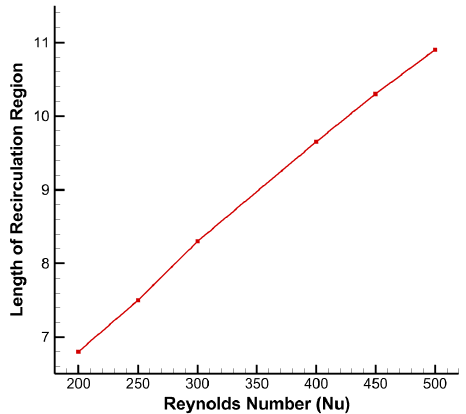
Figure 9. Length of primary recirculation region behind the backward facing step having an expansion ratio of 3.5.